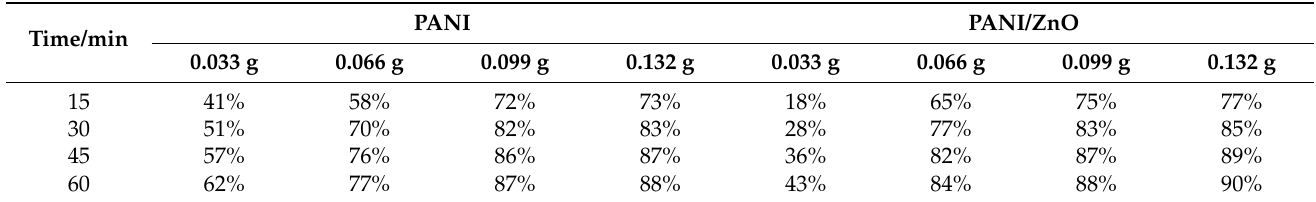
Table 1. The adsorption ratio changes of MO adsorbed by PANI and PANI/ZnO (8%).